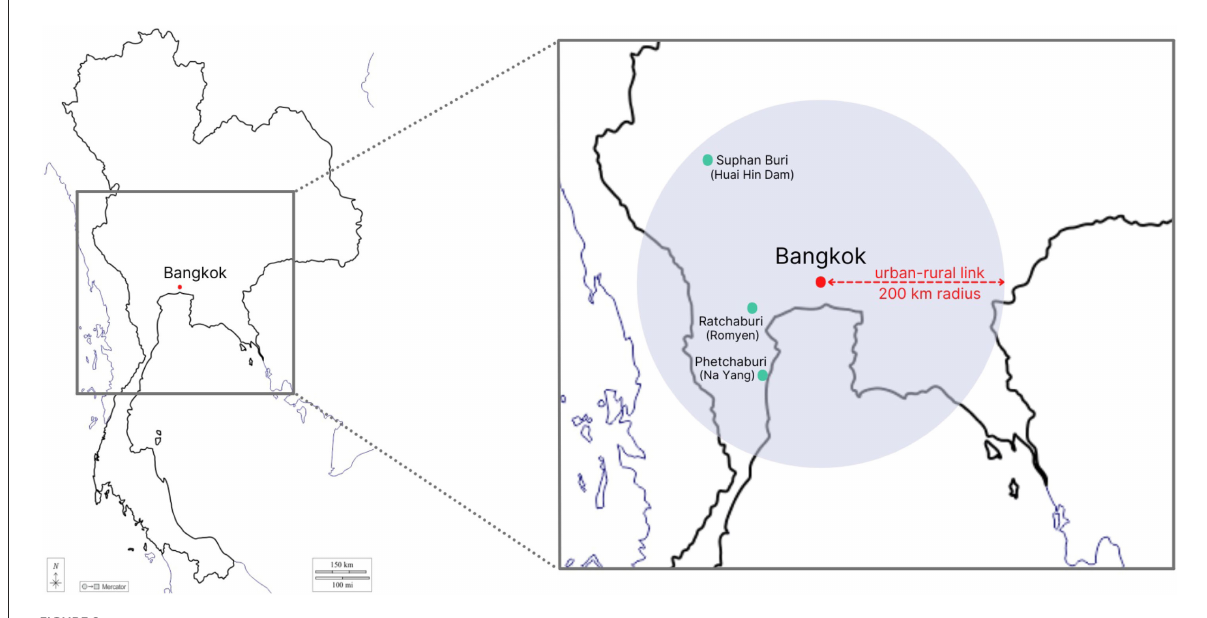
FIGURE2 Map of the three rural case studies selected (source: